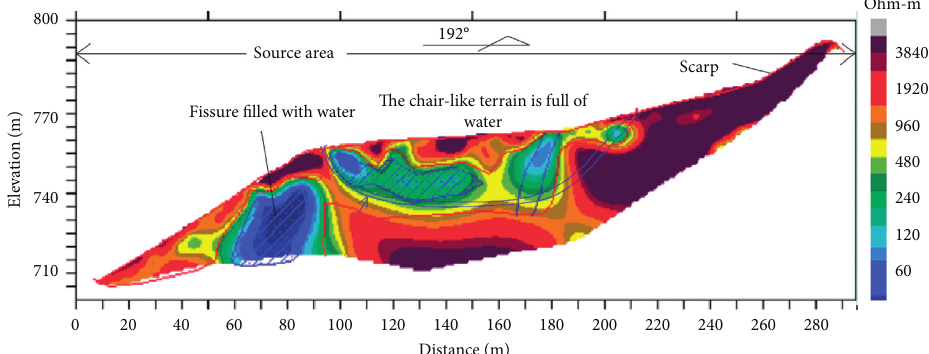
Figure 13: High-density electrical resistivity tomography profiles in the source area (it was taken on September 28, 2016, the topography is like a “chair,” and the resistivity shape underground in the back of the source area is like a